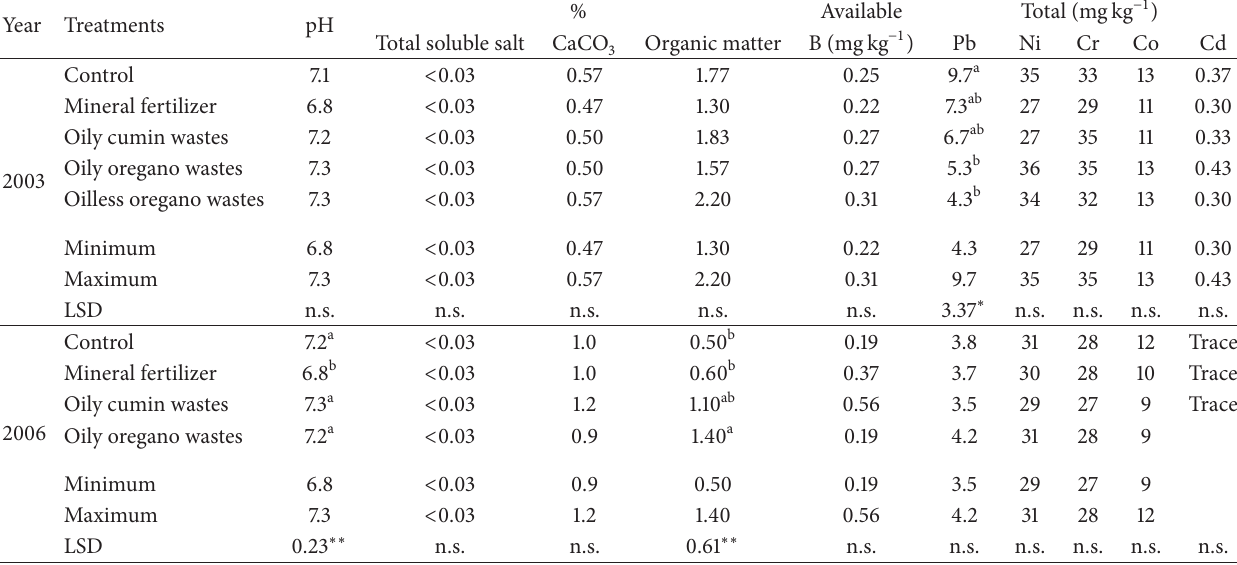
Table 3: Chemical properties of the treated soils (0–20 cm) at harvest in the two experiments. % Year Treatments pH